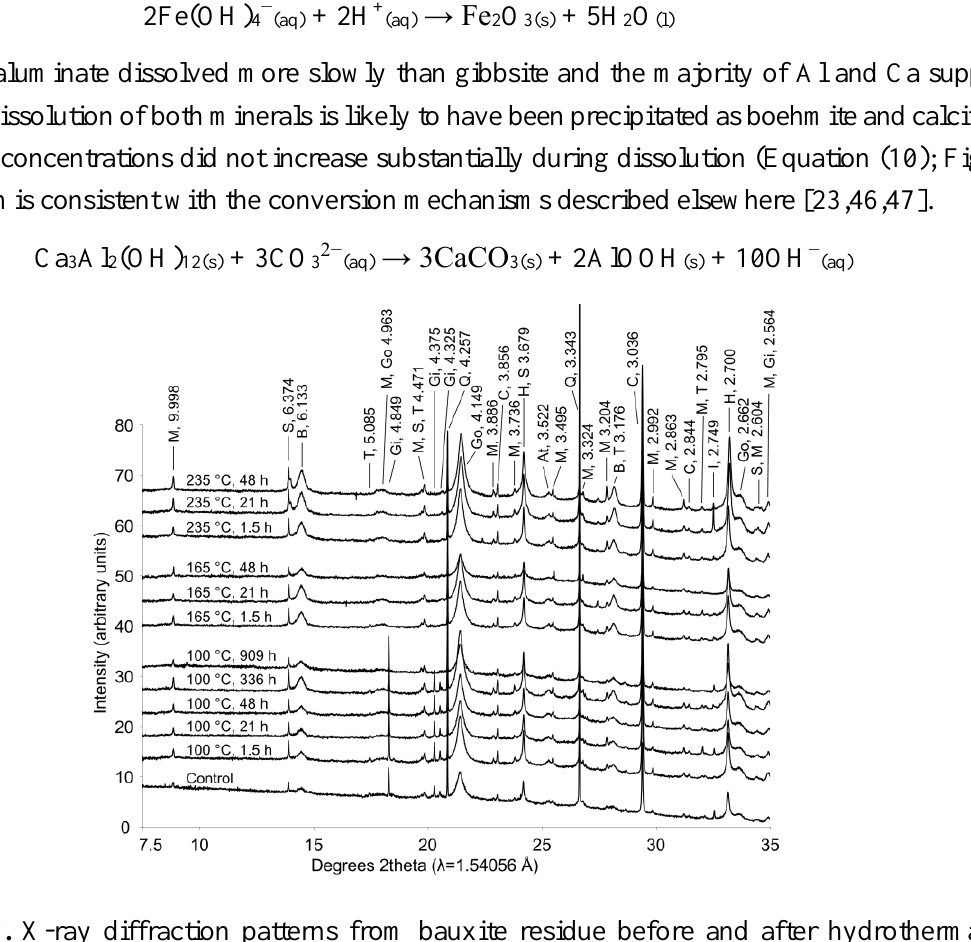
Figure 7. X-ray diffraction patterns from bauxite residue before and after hydrothermal treatment. Treatment time and temperature are indicated for each pattern. Peaks between 7.5°–35° 2θ are labeled with d-spacings (Å) and abbreviations for minerals as follows: M—muscovite; S—sodalite; B—boehmite; T—tricalcium aluminate; Go—goethite; Gi—gibbsite; Q—quartz; C—calcite; H—hematite; At—natase;